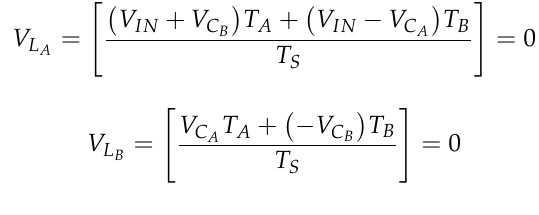
Under the steady condition, the average inductor voltage becomes zero.